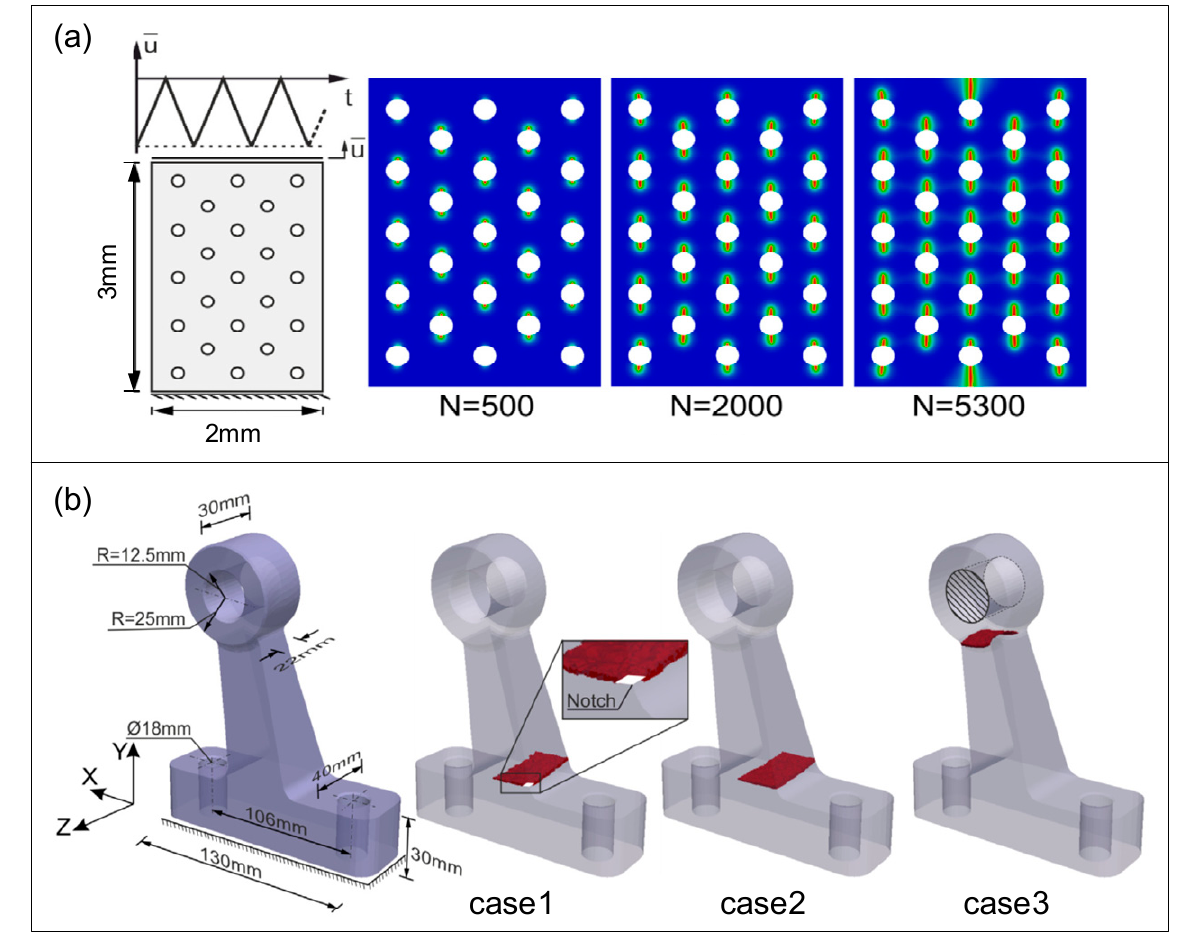
Figure 4. Macroscale brittle fracture. ( a ) A 2D plate with holes model and ( b ) a 3D steering arm model [18].